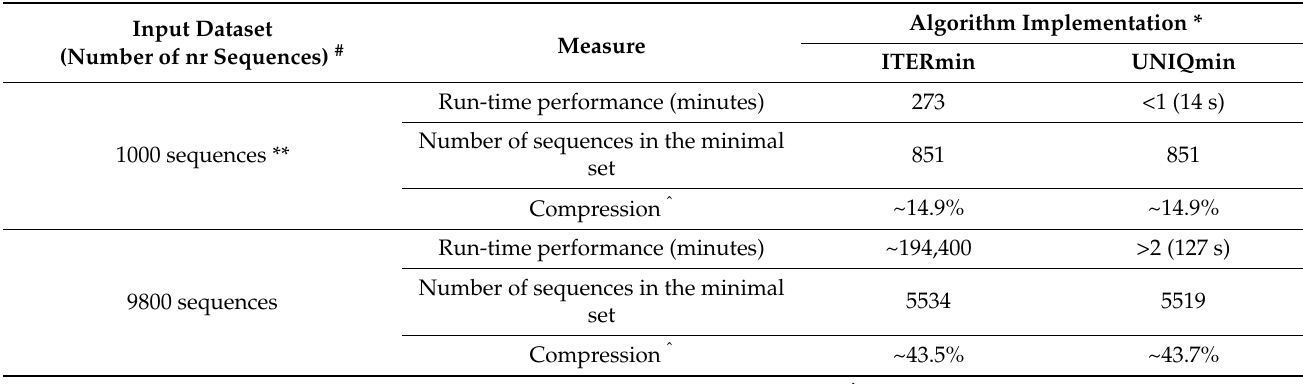
Table 2. Performance evaluation of ITERmin and UNIQmin in generating a minimal set for dengue virus protein sequences. Input